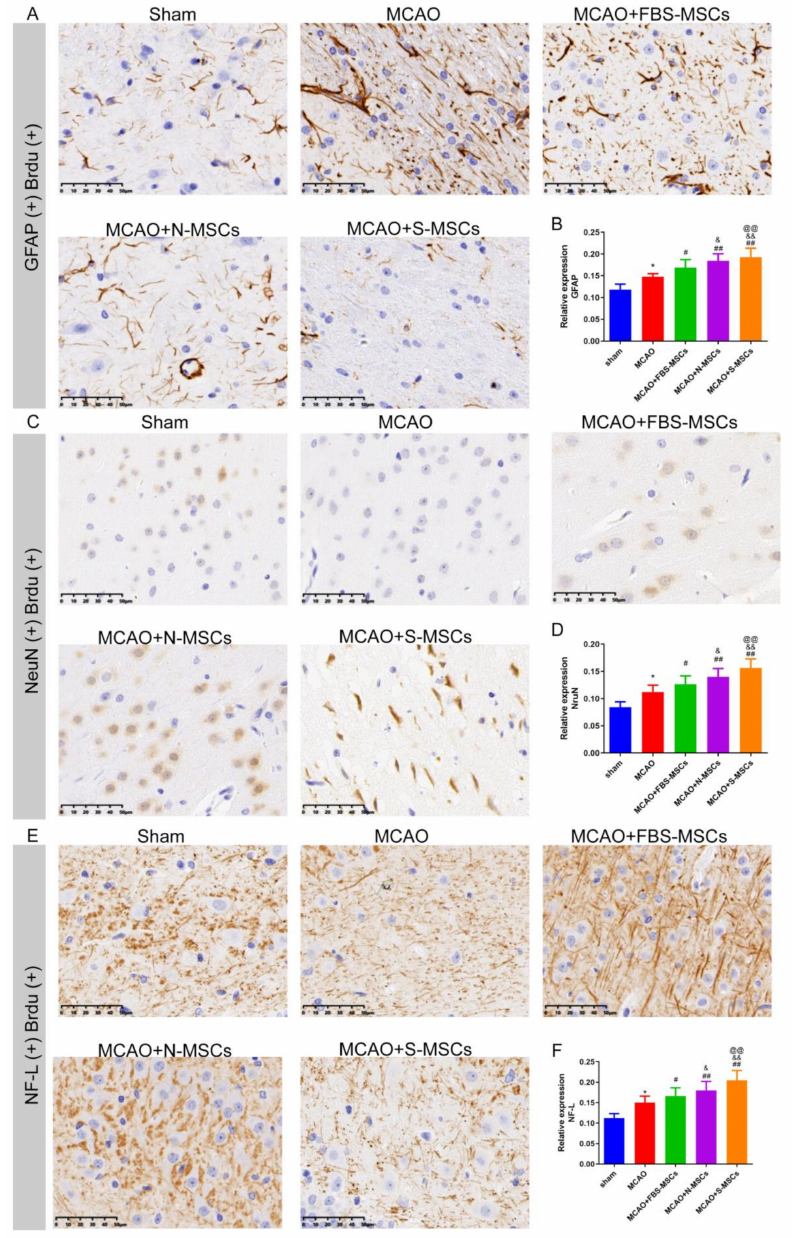
Figure 7. Immunohistochemical detection of GFAP/NeuN/NF-L expression level in brain tis- sue of rats ( × 400). ( x ± s , n = 6) ( A , B ) Immunohistochemical co-localization of GFAP and Brdu; ( C , D ) Immunohistochemical co-localization of NeuN and Brdu; ( E , F ) Immunohistochemical co- localization of NF-L and Brdu. Compared with the sham group, * p < 0.05; compared with the MCAO group, # p < 0.05, ## p < 0.01; compared with the MCAO + FBS-MSCs group, & p < 0.05, && p < 0.01; compared with the MCAO + N-MSCs group, @@ p <